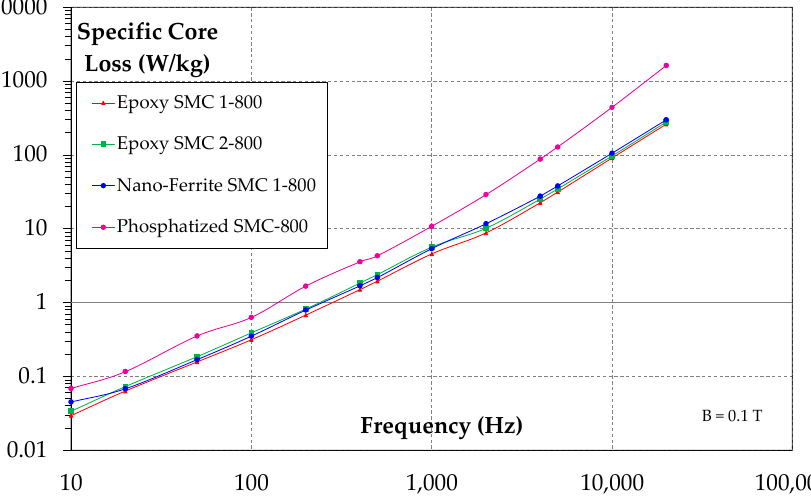
Figure 8. The specific iron losses at 0.1 T of proposed toroid samples in a frequency range of 20 kHz.